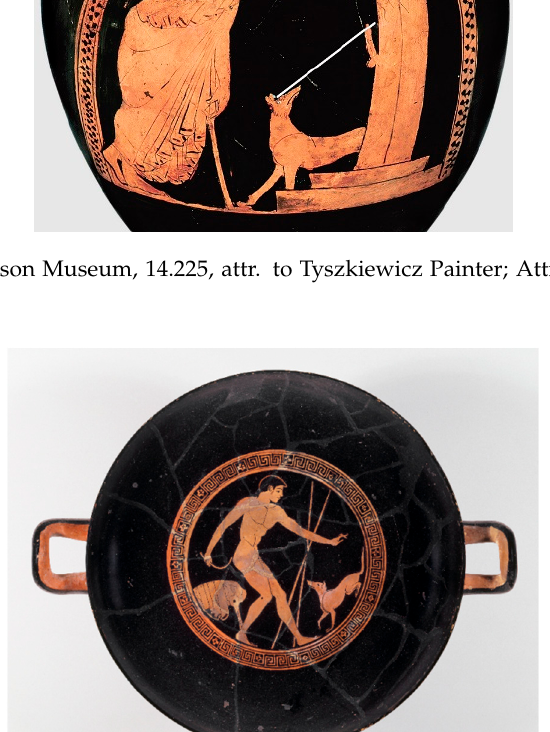
Figure 18. An athlete and his dog. (Museum of Fine Arts, Boston acc. No. 01.8038) Kylix interior; Brygos Painter, 500–450. Image courtesy of the Museum of Fine Arts, Boston.